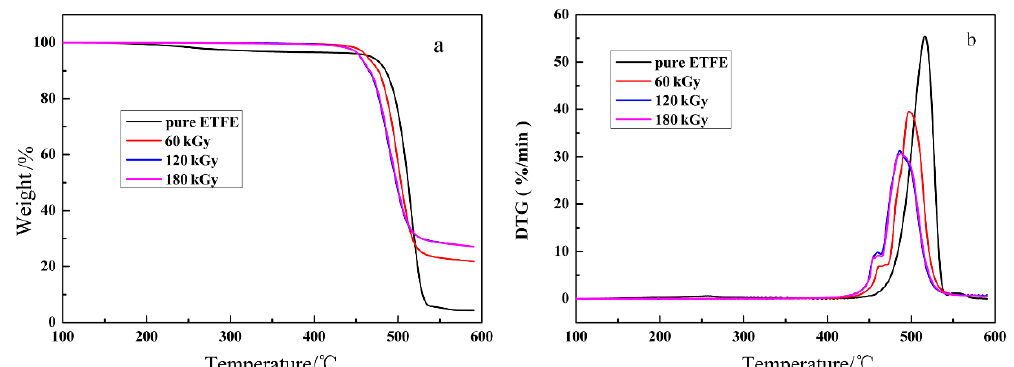
Figure 2. Thermo-gravimetric analysis (TGA) ( a ) and derivative thermogravimetry (DTG) ( b ) curves for samples pristine and irradiated at various doses.